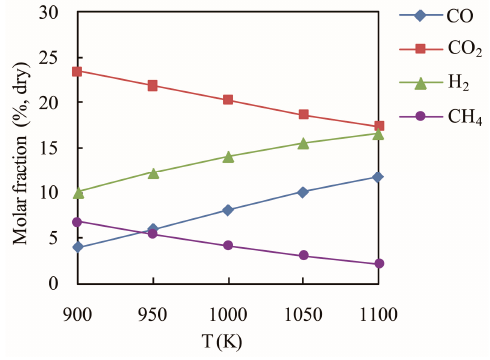
Figure 9. Effect of gasification temperature on syngas composition at ER = 0.4 and SBR = 0.5.